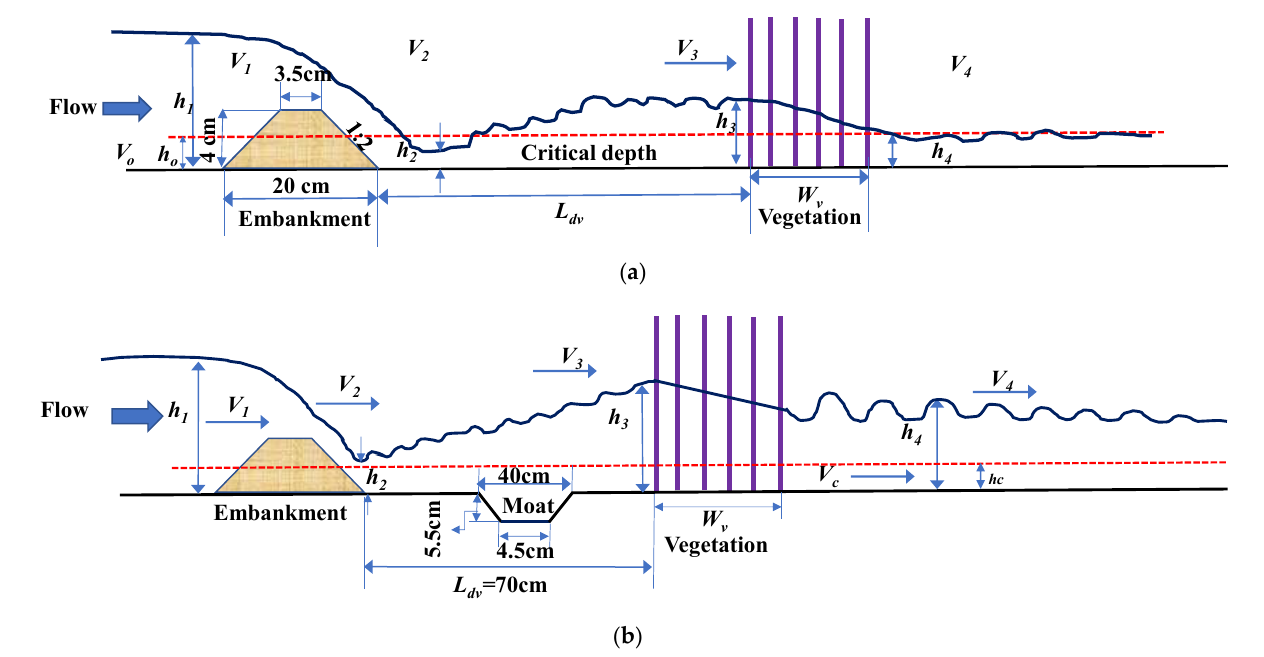
Figure 2. Illustration of free-water surface characteristic profiles for the cases of: ( a ) embankment and vegetation (EV) model; ( b ) embankment, moat, and vegetation (EMV) model.